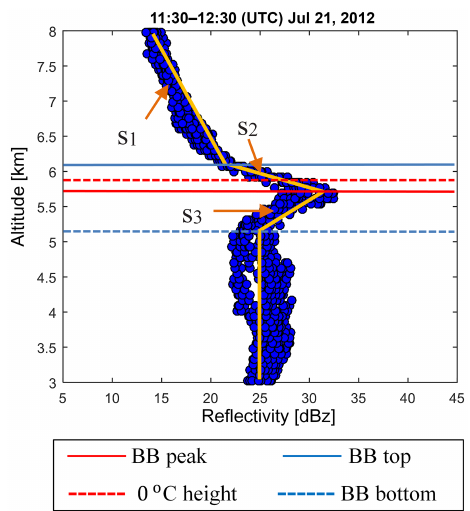
Figure 5. A real sample of VPR model processed in the study on 21 July 2012. The blue circle represents azimuthal mean of reflec- tivity over 1h. The orange line represents the idealized VPR with piecewise linear slope α , β and γ . The horizontal blue line is the bright band (BB) top and dashed blue line is BB bottom. The solid red line and dashed red line are BB peak and the 0 ◦ C height, re-